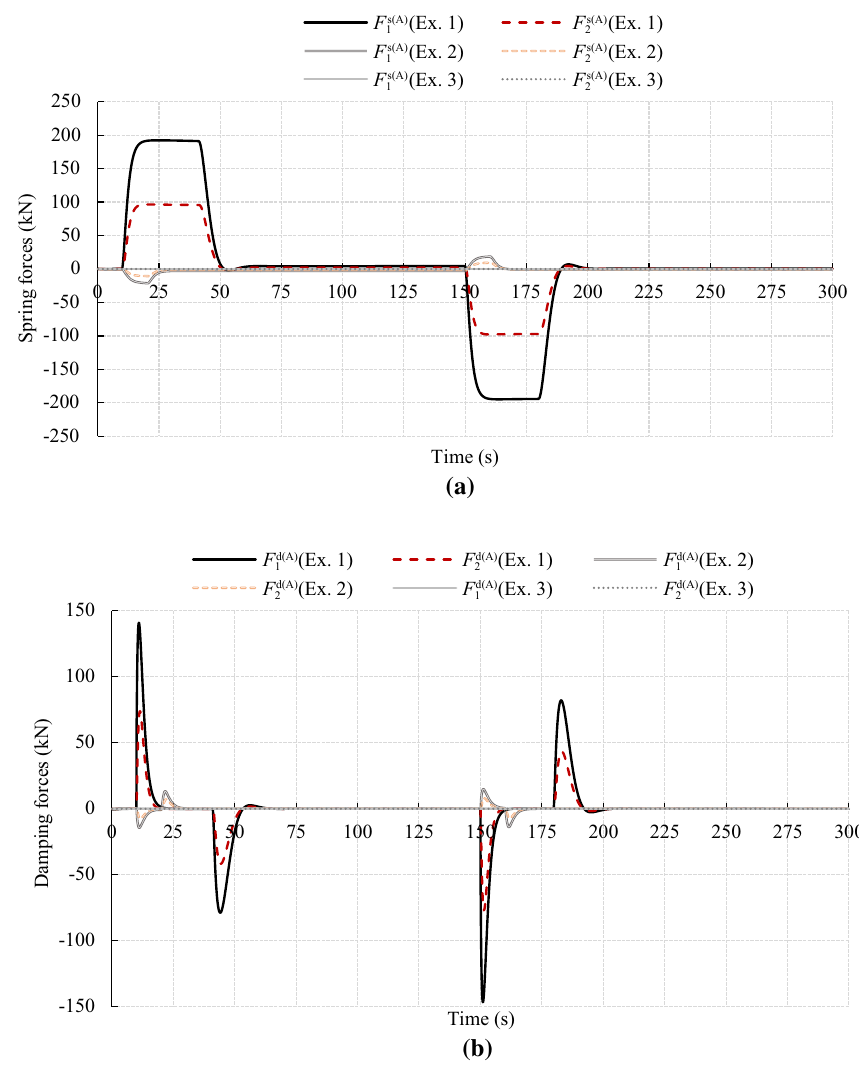
Fig. 7 Numerical results based on the LTD for model A of the MUT: a coupler spring forces F s A ð Þ F d A ð Þ and F d A ð Þ vs. time (in Ex. 1 and 2, passive vibration damping is only used; in Ex. 3 both passive and active vibration damping are 1 2